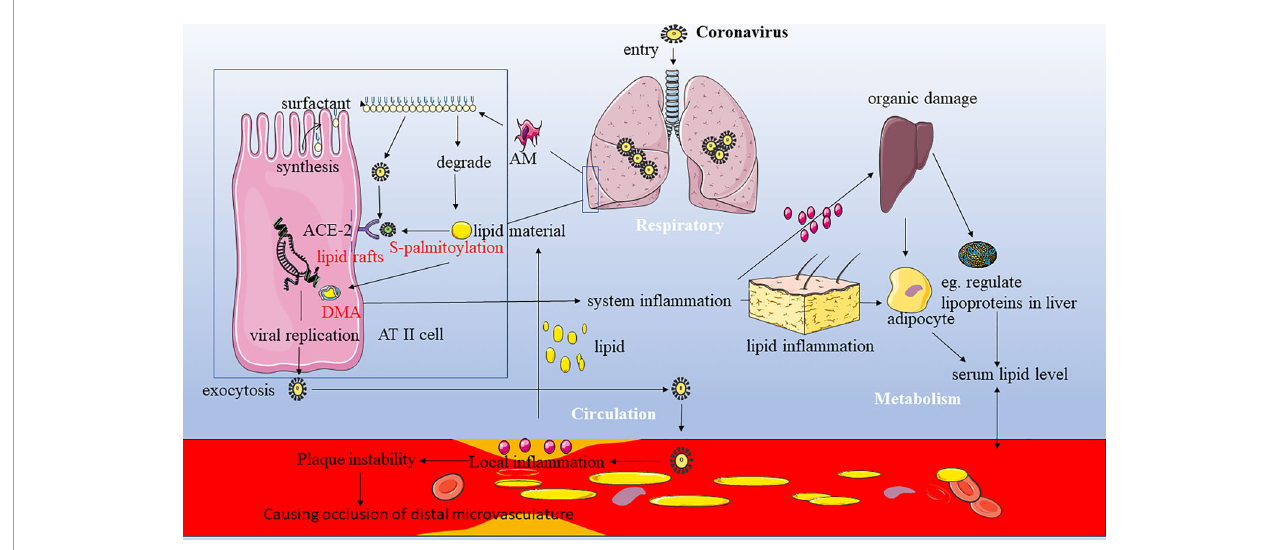
FIGURE 4 | The potential bidirectional interaction between the host lipids and COVID-19 and the role of lipid in viral entry and invasion. Combining our results above with the viewpoints from previous studies (Guan et al., 2020; Mehra et al., 2020; Radenkovic et al., 2020; Alketbi et al., 2021), we have provided the model fi gure to help us understand the underlying mechanisms to explain the bidirectional interaction between host lipid metabolism and SARS-CoV-2 which led to the poor progression of COVID-19. ACE-2, angiotensin-converting enzyme 2; AM, alveolar macrophage; ATII, alveolar type II cells; DMV, double-membrane